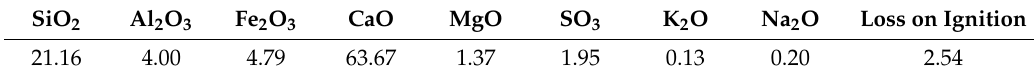
Table 2. Chemical composition of type V Portland cement (% by weight).